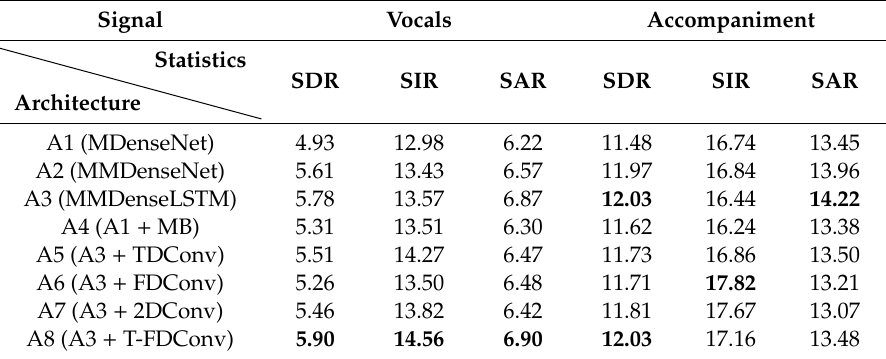
Table 1. Separation performance (dB) on DSD100 dataset.